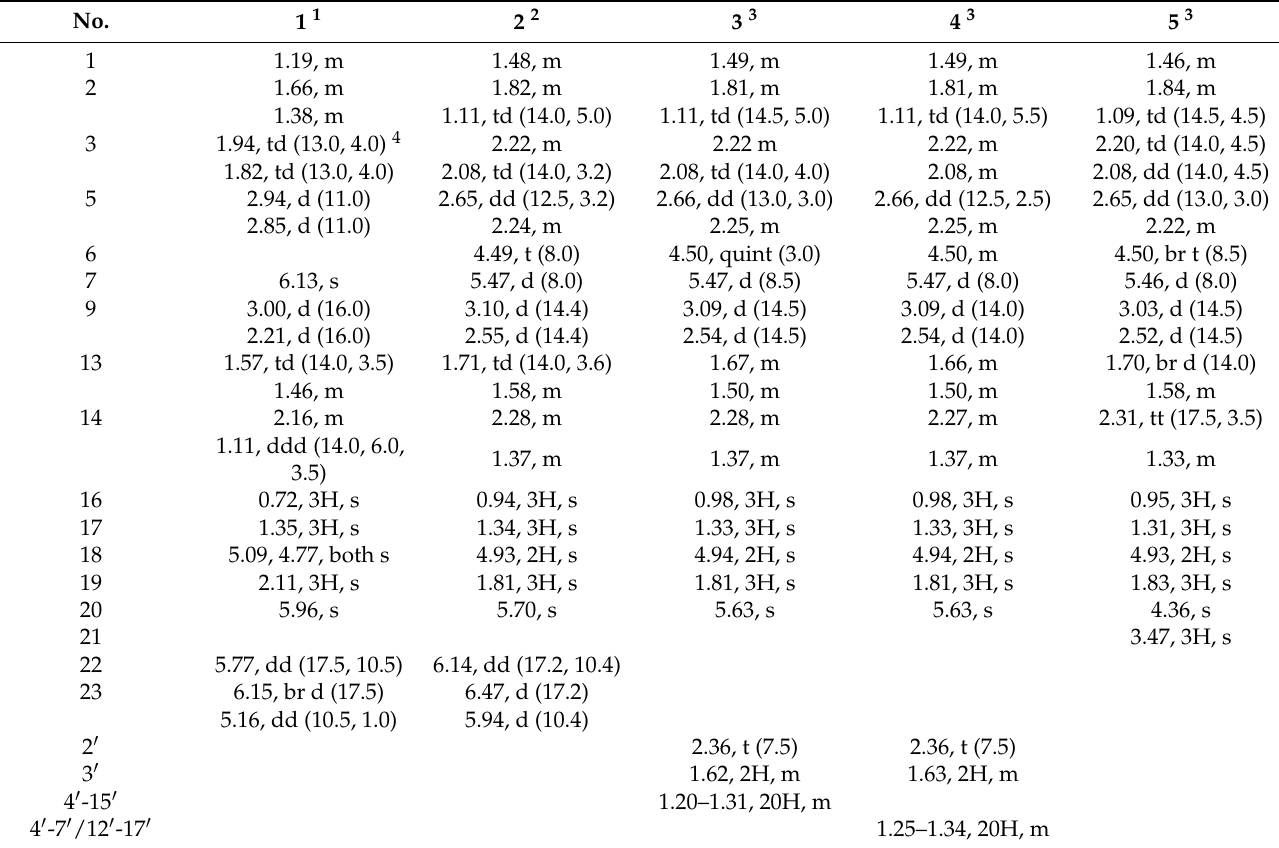
Table 2. 1 H NMR spectroscopic data of compounds 1 – 5